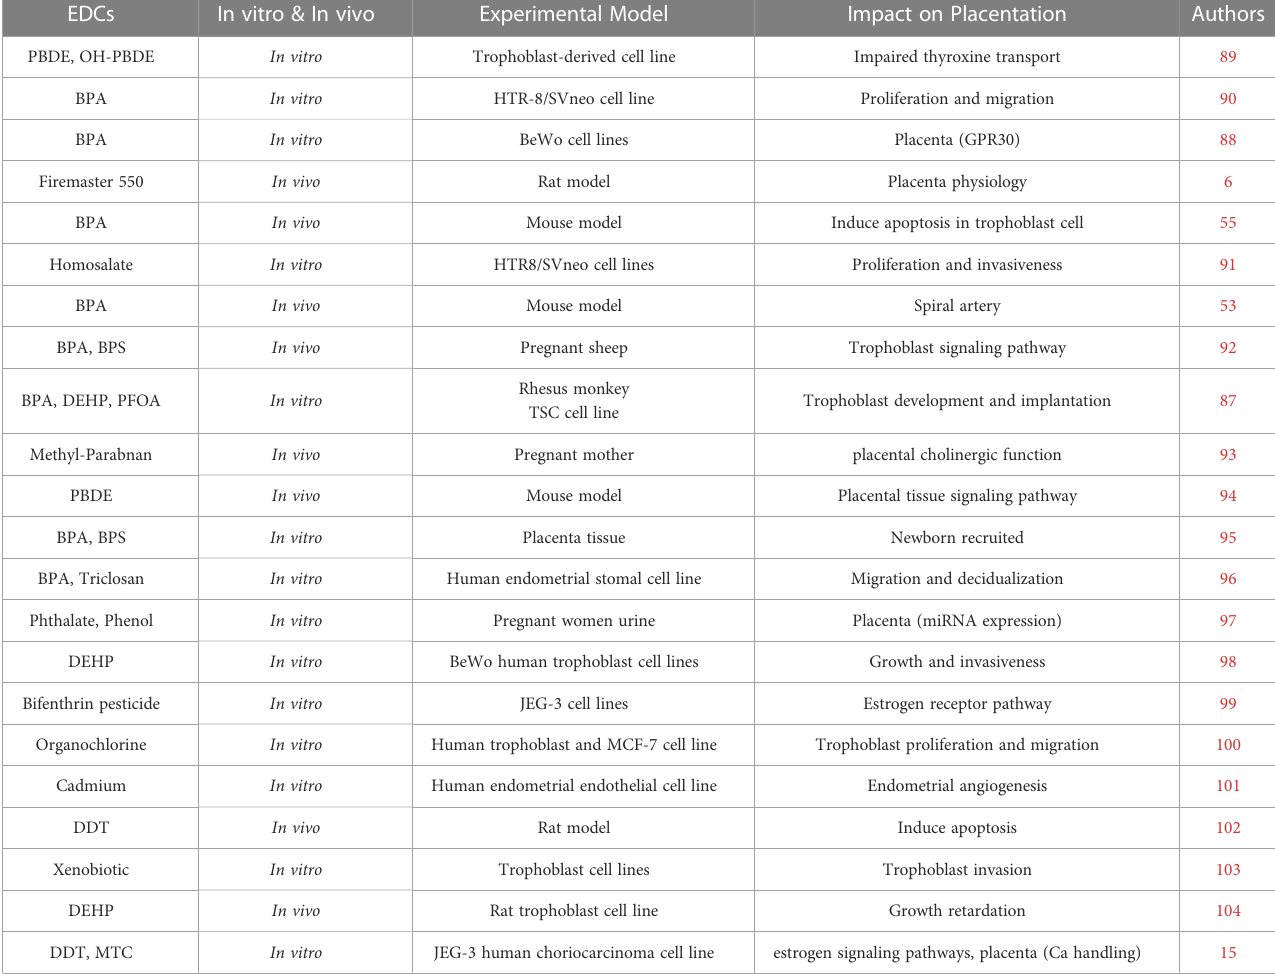
TABLE 1 Worldwide In vitro and In vivo studies on EDCs exposure impact on placenta and placenta development. EDCs In vitro & In